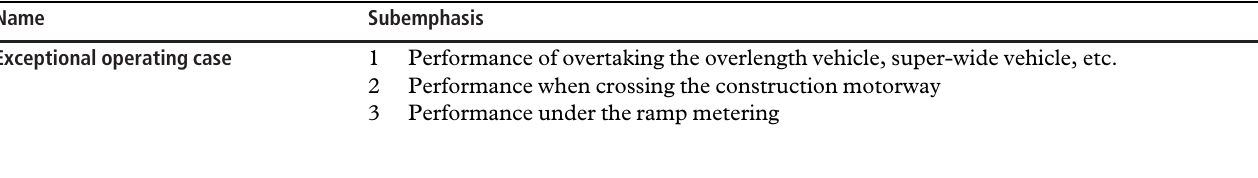
Table 6 Details of the exceptional operating case